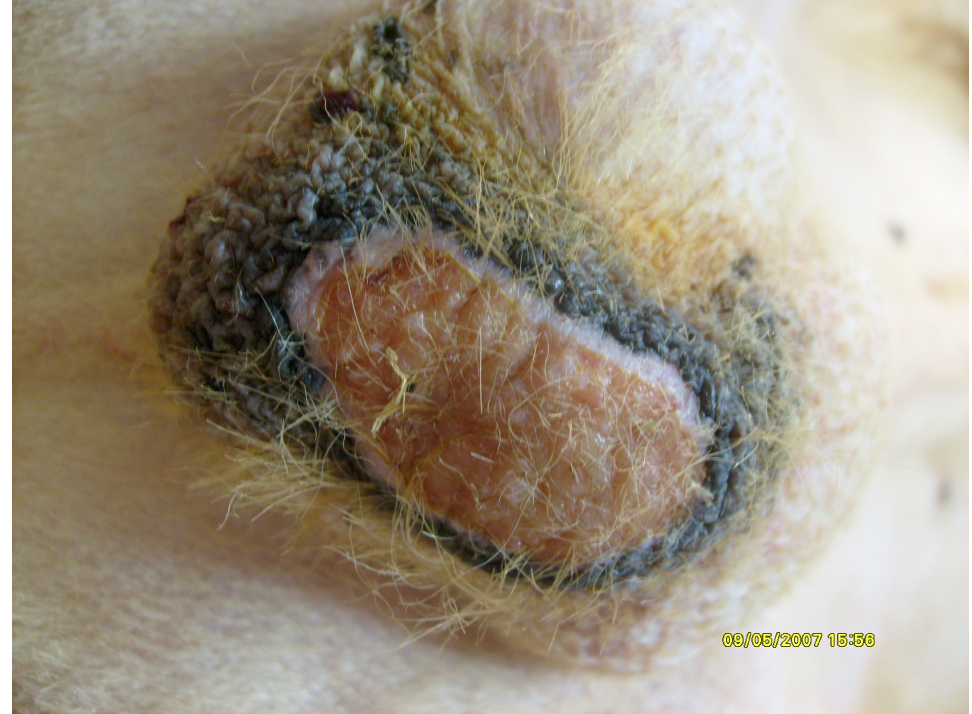
figure 1. Canine Scrotal image with persistent ulcerated